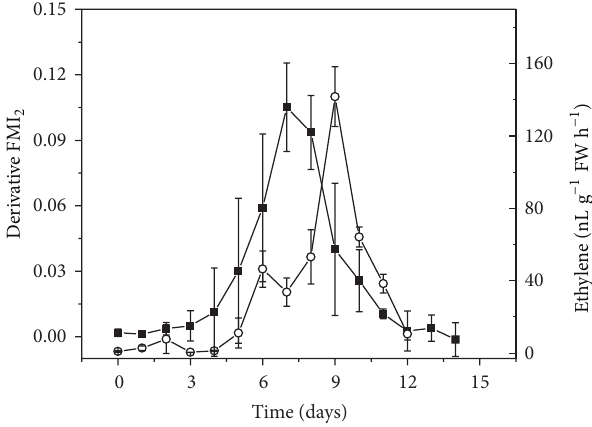
Figure 5: FMI 2 derivative time evolution (black square—left axis) and the ethylene time evolution (white circle — right axis) from